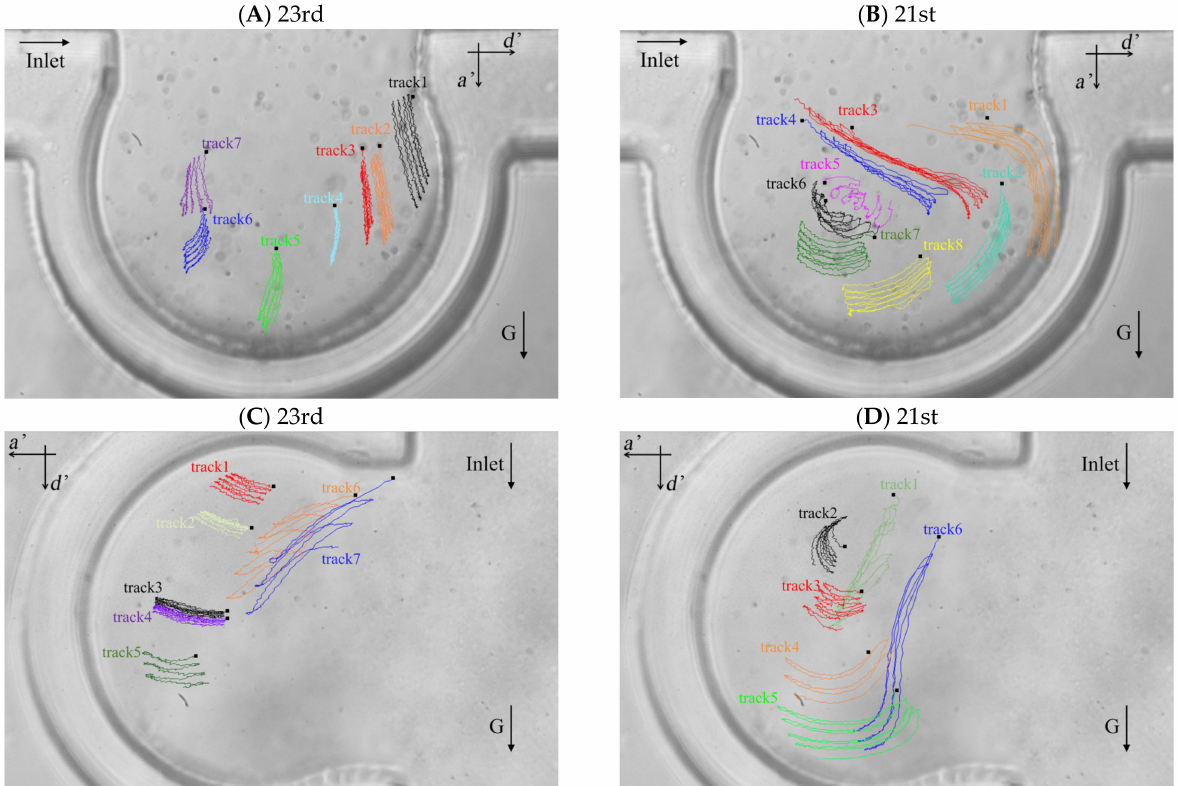
Figure 4. Particle trajectories in the alveolar chip. ( A ) Particle trajectories in the alveolus of the 23rd generation with gravity direction perpendicular to the ductal flow. ( B ) Particle trajectories in the alveolus of the 21st generation with gravity direction perpendicular to the ductal flow. ( C ) Particle trajectories in the alveolus of the 23rd generation with gravity direction parallel to the ductal flow. ( D ) Particle trajectories in the alveolus of the 21st generation with gravity direction parallel to the ductal